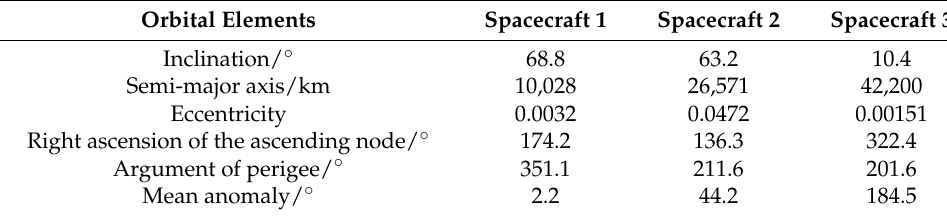
Table 1. Orbital elements of the spacecraft [24].